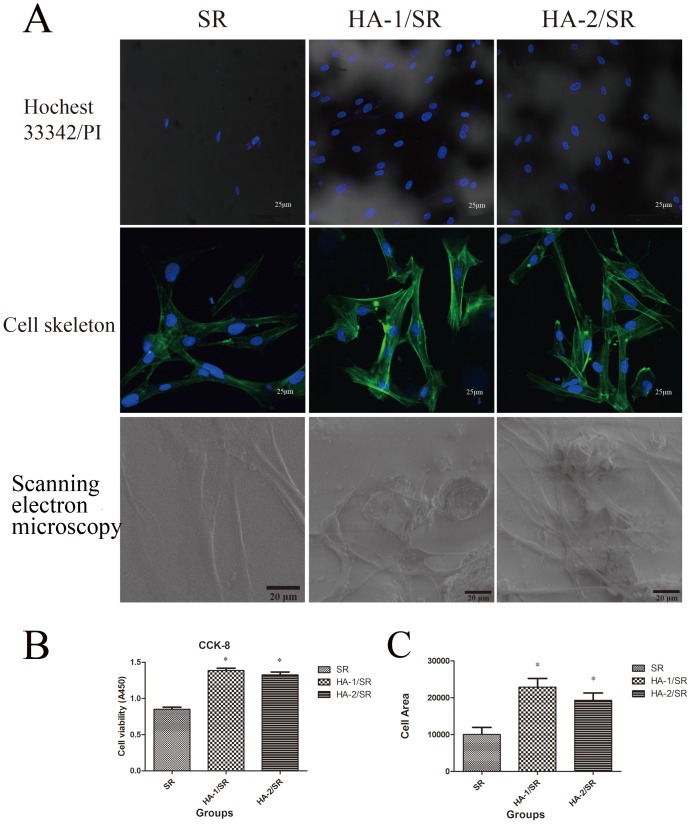
Cell compatibility of HA coated SR.A, Cytotoxicity of materials according to Hoechst 33342 double staining with PI (Left, SR; Middle, HA-1/SR; Right, HA-2/SR); Cell skeleton structure staining of each group (Left, SR; Middle, HA-1/SR; Right, HA-2/SR) (the scale bar is 25 µm); SEM images further demonstrated a more fibroblastic appearance of fibroblasts cultured on HA/SR (the scale bar is 20 µm); B, Cell proliferation of each group studied by CCK-8 (n = 6, *p<0.05); C, Cell area of each group studied by IPP6 (n = 6, *p<0.05).